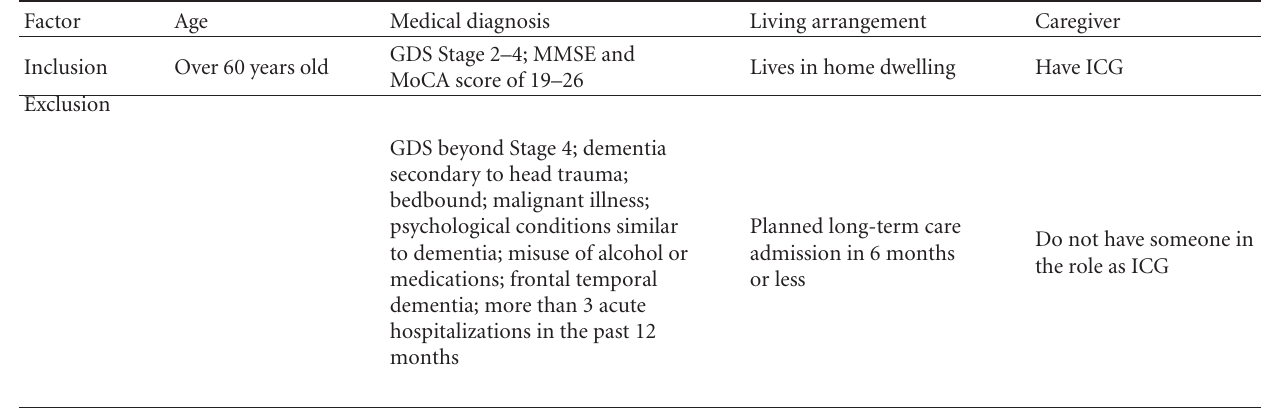
Table 1: Inclusion and exclusion criteria for EPs.